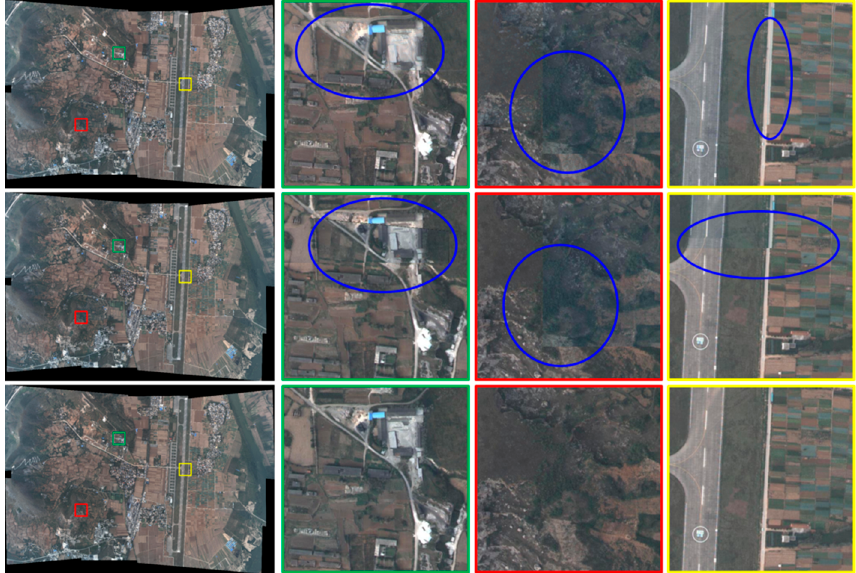
Figure 12. Comparison of different mosaicking methods: the first row is the pixel fusion method; the second row is the two-image overlap seamlines method and the third is the multi-image overlap seamlines method.